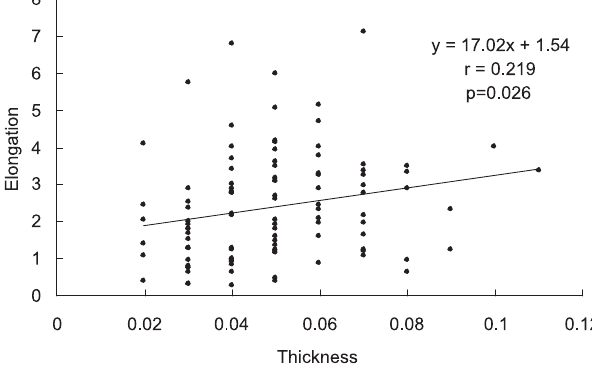
Figure 3 - Correlation between elongation and thickness